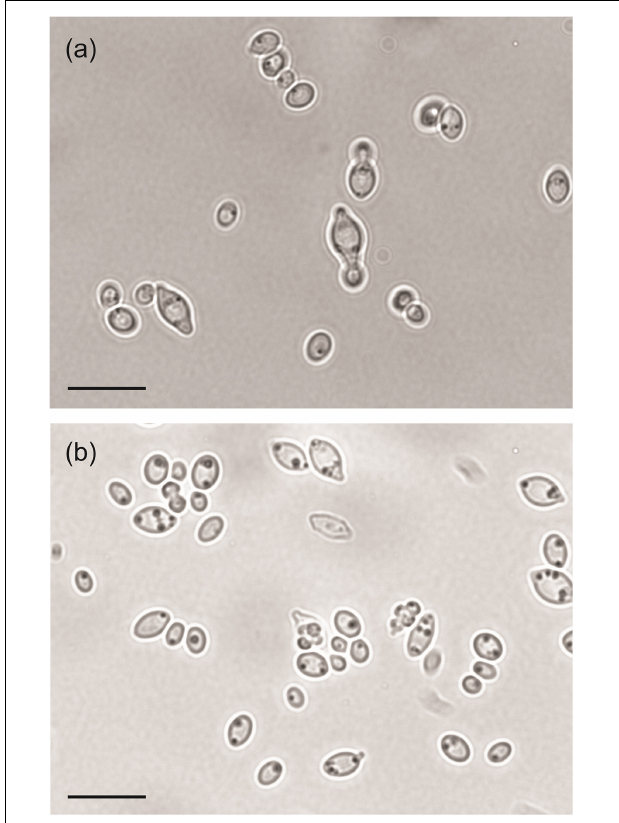
FIGURE 5 | Microphotographs of Hanseniapora smithiae sp. nov. CRUB 1928 T . (a) Budding cells; yeast–malt broth, 25 ◦ C, 220 rpm, 2 days. (b) Hat-to-helmet shaped ascospores released from the ascus; 5% malt extract agar, 14 days at 25 ◦ C. Scale bars, 10 µ